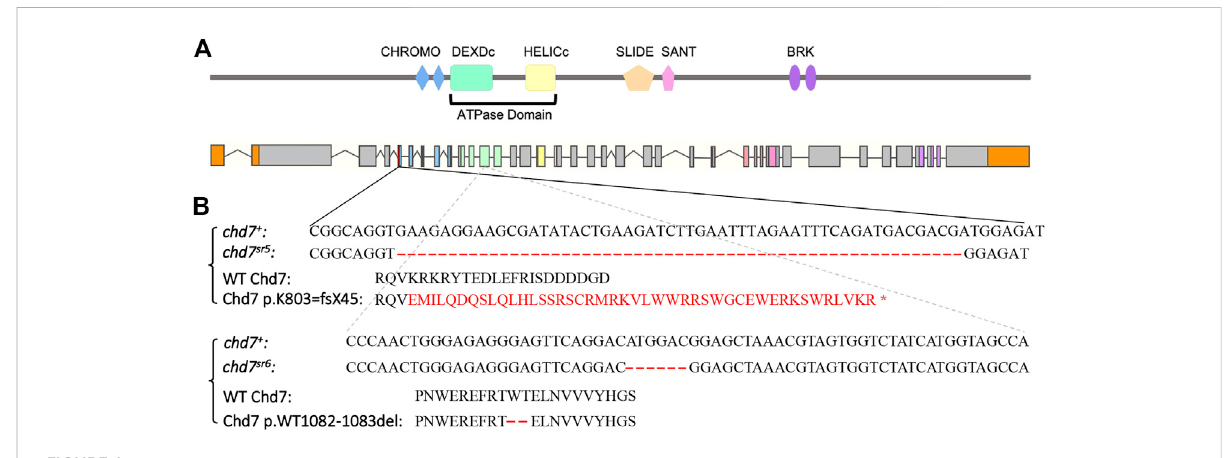
FIGURE 1 Generation of chd7 zebra fi sh mutants. (A) Schematics of Chd7 protein and chd7 gene structure. Chd7 protein contains double CHROMO domains, an ATPase domain including a DEXDc and HELICc domain, a SLIDE/SANT domain, and double BRK domains. (B) Sequence of the chd7 sr5 and chd7 sr6 mutants. Chd7 sr5 contains a 55-bp deletion in the fi fth exon of chd7 , which generated a truncation after the fi rst chromo domain. The deletion created a 44-amino acid frame-shift followed by a stop codon. Chd7 sr6 has a mutation in the twelfth exon, which encodes the DEXDc domain, and causes a deletion of two amino acids, tryptophan and